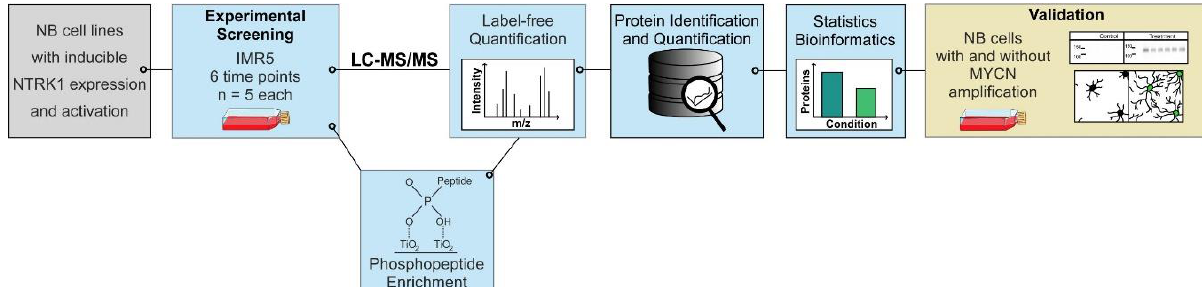
Figure 1 . Schematic representation of the experimental workflow. For experimental screening, IMR5 cells underwent time course stimulation with NGF followed by proteome and phosphoproteome analysis, respectively. The generated data were statistically analyzed and selected proteins were further investigated in four NTRK1-expressing cell lines to validate the observations.